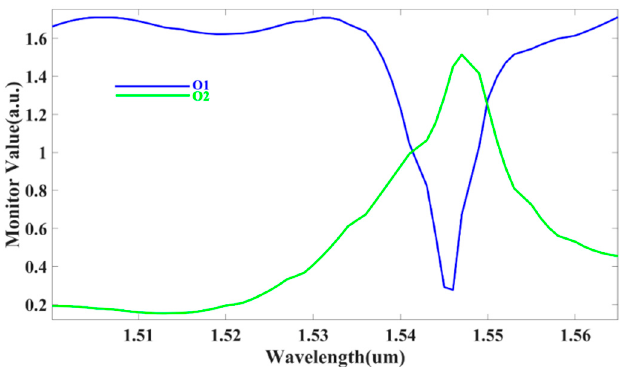
Figure 3. Response of the switch for different wavelengths.